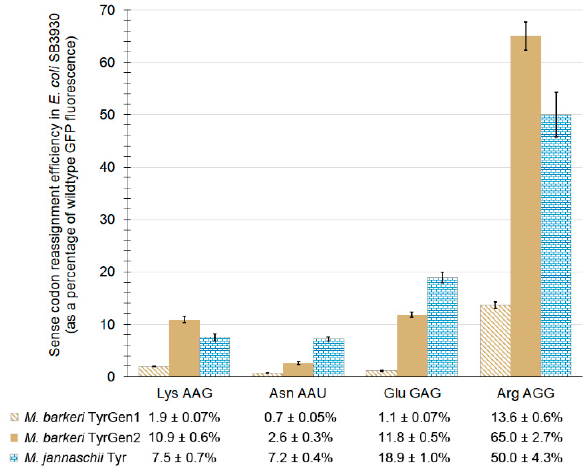
Figure 3. Reassignment efficiency of four sense codons in E. coli SB3930 by three orthogonal tRNA/aaRS pairs: M. barkeri TyrGen1 (gold, partly shaded bars); M. barkeri TyrGen2 (gold, fully shaded bars); M. jannaschii Tyr (blue, partly shaded bars, previously reported [17,32,33]). For each evaluation, a GFP reporter vector with the targeted codon specifying the tyrosine residue required for GFP fluorophore formation is combined with a vector expressing the orthogonal aminoacyl tRNA synthetase specified and its cognate tRNA with an anticodon capable of Watson–Crick base pairing to the targeted codon. Efficiencies are calculated relative to a “100% fluorescence control”, a GFP reporter with a tyrosine codon specifying the fluorophore, and a non-fluorescent “0% fluorescence control”, a GFP reporter with a non-tyrosine codon specifying the fluorophore. Table 2. Impact of sense codon reassignment by the TyrGen2 orthogonal pair on cellular fitness. Codon Reassigned